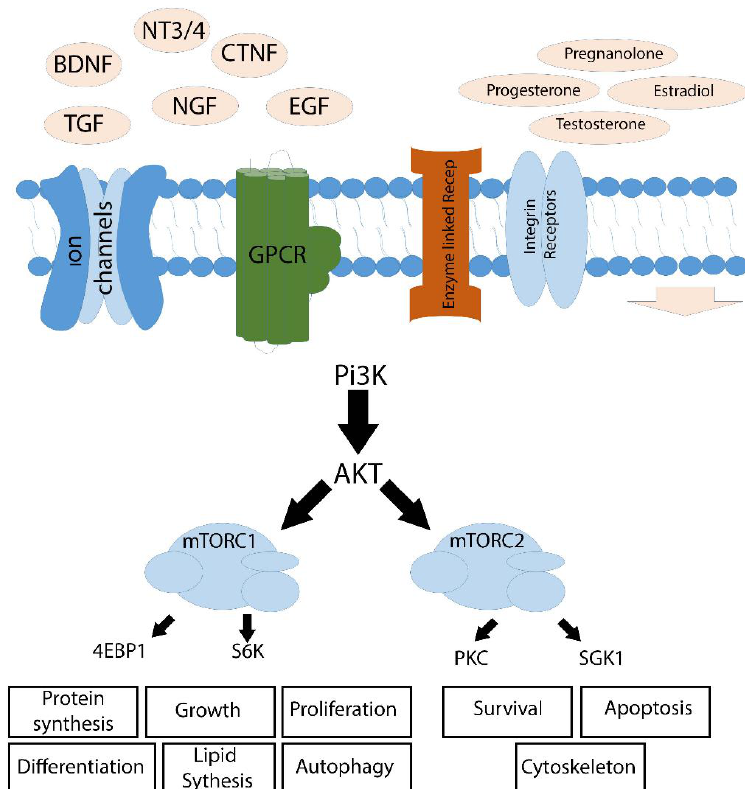
Figure 2. The interplay of neurotrophic factors, steroids, and intra-cellular signaling, in growth and differentiation of neural tissue. Cells sense different cues in the extracellular environment through membranous receptors, and these changes are communicated downstream through cascades of protein/cytoplasmic factor activation and inactivation. Many of these changes go through Protein kinase B or AKT, and mammalian target of rapamycin (mTOR), which further stimulate ribosomal proteins, i.e., 4EBP and S6 kinases, as well as PKC and SG1K. Stimulation of ribosomal proteins leads to protein synthesis, proliferation, growth, and differentiation; whilst PKC and SGK1 activation suppresses apoptotic pathways and improves survival. Abbreviations: BDNS (brain-derived neurotrophic factor), NT3 (Netrins 3), TGF (transforming growth factor), NGF (nerve growth factor), EGF (epithelial growth factor), CTNF (ciliary neurotrophic factor), GPCR (G protein-coupled receptor), Pi3K (phosphoinositide 3 kinase), Akt (protein kinase b), mTORC1 (mammalian target of rapamycin complex1), mTORC2 (mammalian target of rapamycin complex 2), 4EBP (eukaryotic initiation factor 4 binding protein), S6K (ribosomal protein S6 kinase), PKC (protein kinase c), SGK1 (glucocorticoid regulated kinase 1). 5.6. Insulin and Neurodegeneration In the central nervous system, insulin signaling promotes differentiation, proliferation, and neurite growth, and possesses neuroprotective and anti-apoptotic activity [327]. Insulin also modulates the structure and function of synapses, neurons, and neuronal circuits while playing a role in learning, cognition, and memory [327]. Neurochemical changes in neurodegenerative diseases may relate to abnormalities in glucose metabolism in vivo [328]. Brain insulin resistance partly drives cognitive impairment and AD in humans with peripheral insulin resistance diseases, including diabetes mellitus and metabolic syndromes [329,330]. Brain insulin resistance is also associated with increased levels of phospho-Tau and Aβ42 [331].